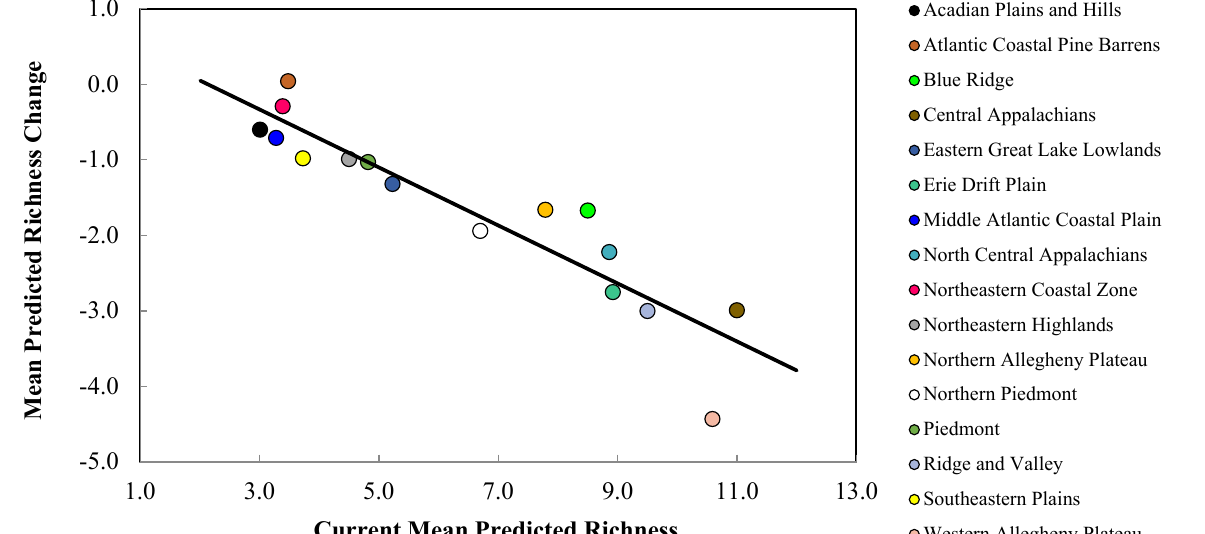
Figure 6. Mean current predicted refugia richness ( i.e. , number of species with a climatically-suitable niche in a landscape patch) versus mean predicted change in refugia richness for priority salamander species in northeastern U.S. EPA Level III ecoregions (Figure 1). Current predicted richness and mean predicted richness loss values were obtained from Tables 4 and 5, respectively. Ecoregion markers at greater distances above and below the best fit line indicate proportionally lesser and greater predicted changes, respectively in refugia richness due to climate